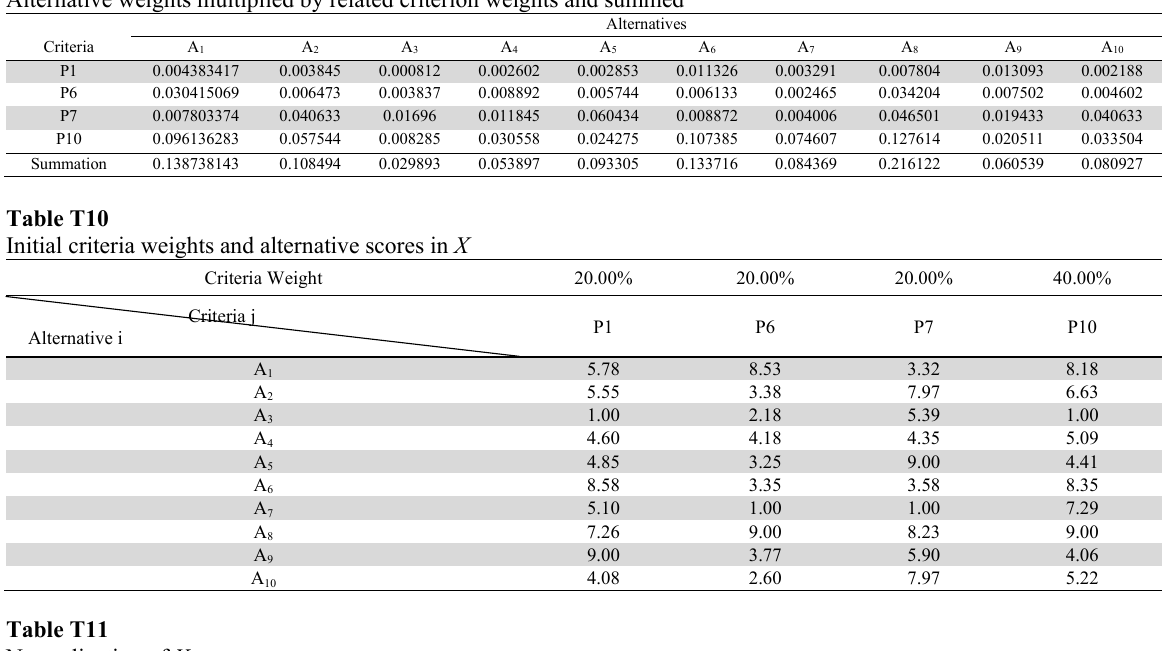
Alternative scores and criterion weights Criteria